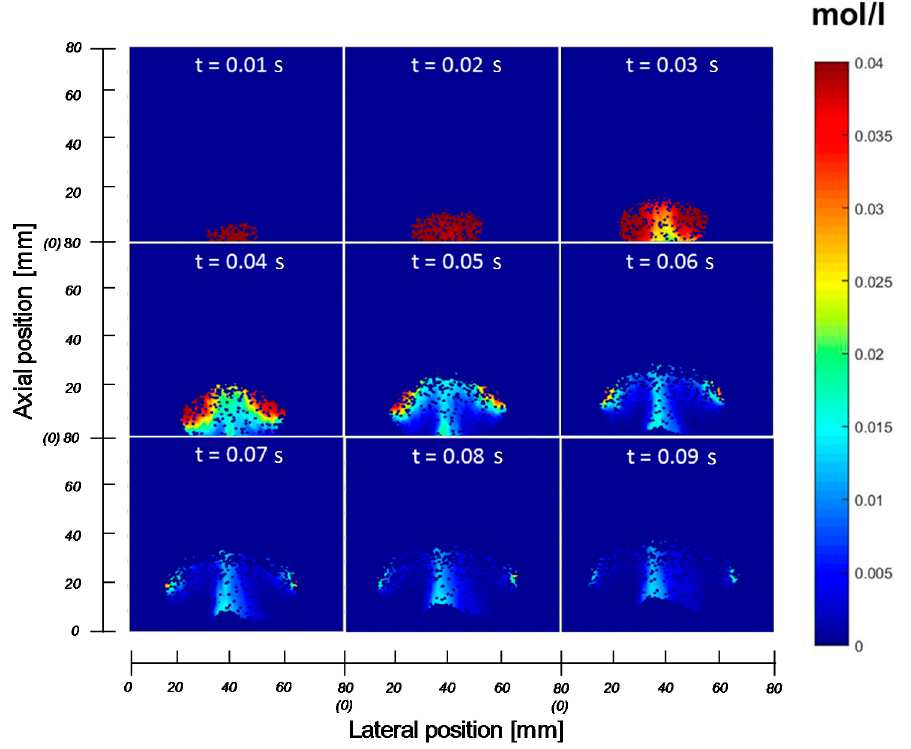
Figure 10. Tracer gas concentration profiles inside an injected bubble in a bed at minimum fluidization conditions using the IR technique as a function of time (t) in seconds.